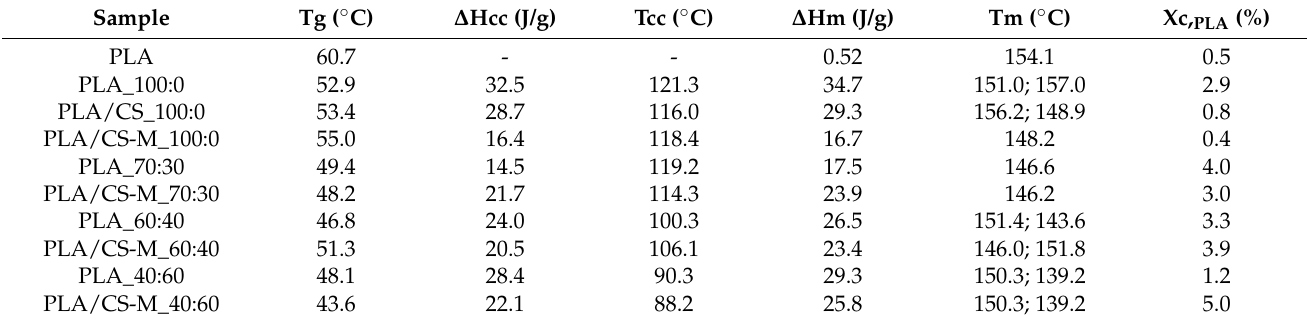
Figure 6. Differential scanning calorimetry (DSC) curves (exo up), the second heating run, for neat PLA, PLA with MB/PEG bio-plasticizers: ( a ), and PLA-based biocomposites containing CS-M: ( b ). Table 3. Thermal parameters evaluated from DSC curves for PLA-based biocomposites plasticized PLA and neat PLA.